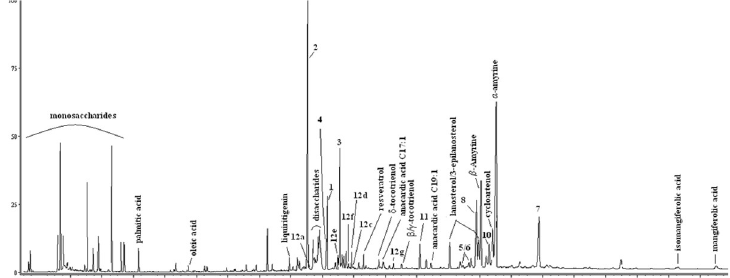
Fig 1. GC chromatogram of 70% ethanol propolis extract. The numbers of compounds identified correspond to those of isolated compounds.